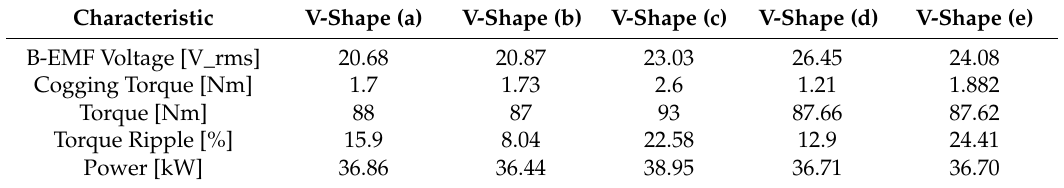
Figure 3. Back electromotive force voltage, cogging torque, and torque ripple according to notch position: ( a ) back electromotive force voltage; ( b ) cogging torque; ( c ) comparative analysis of torque ripple. Table 2. Comparative analysis of cogging torque and torque ripple according to notch position.